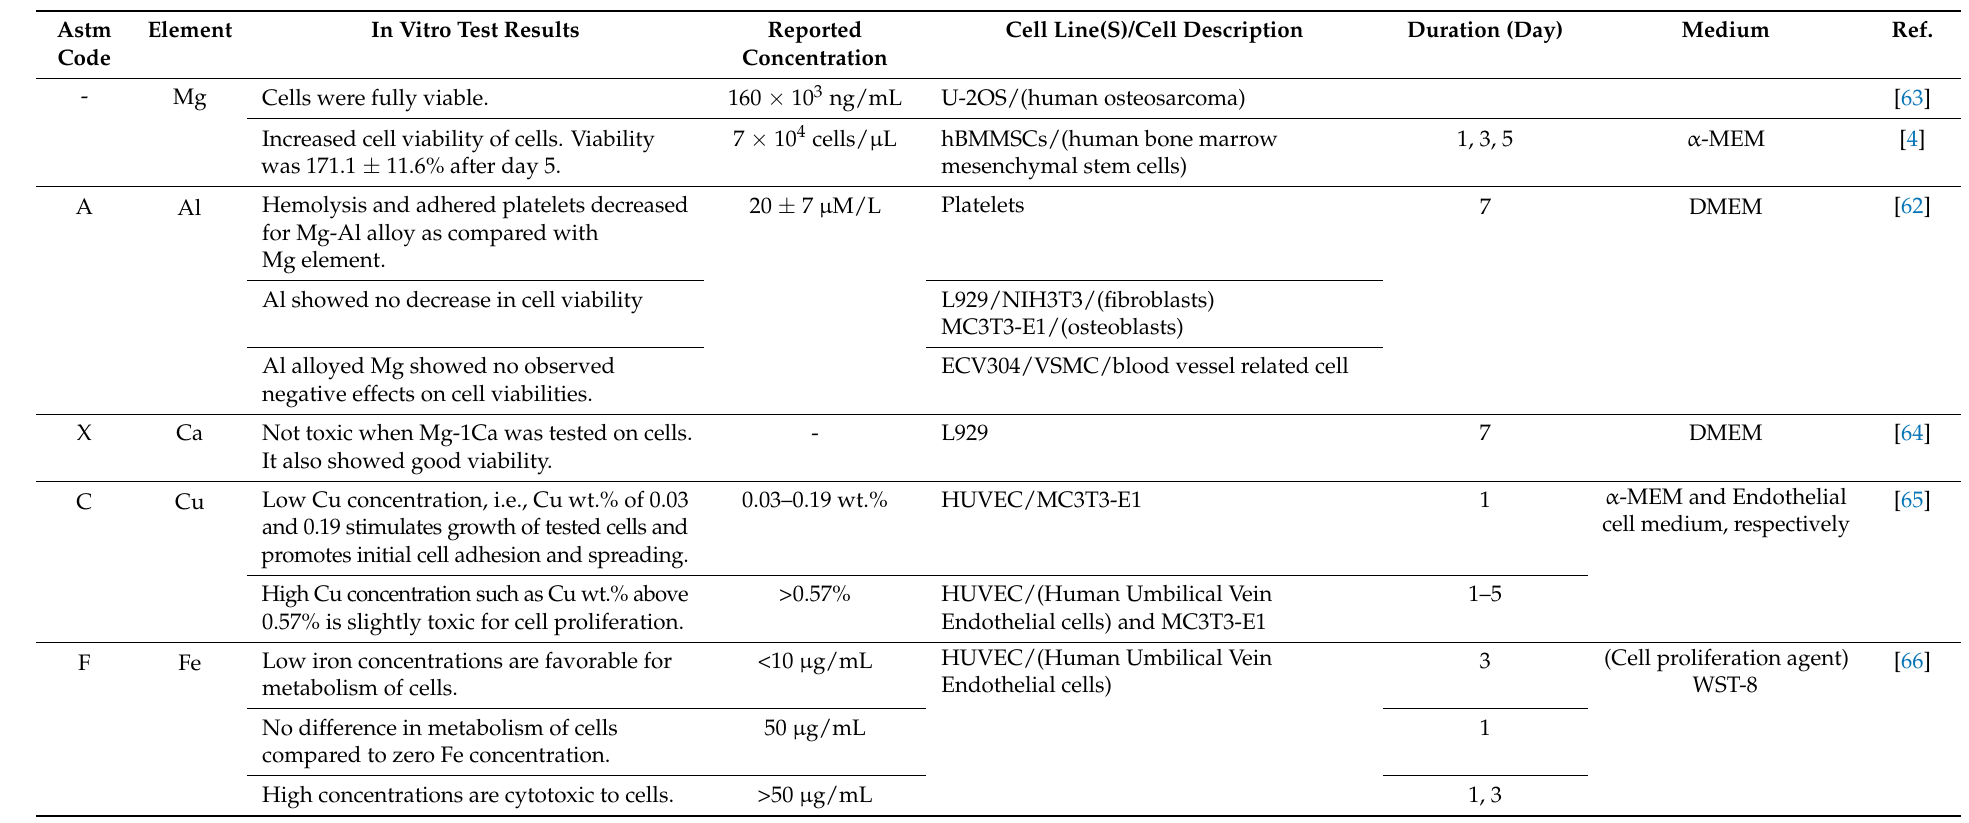
Table 2. In vitro cytotoxicity test results for various cell lines as found in